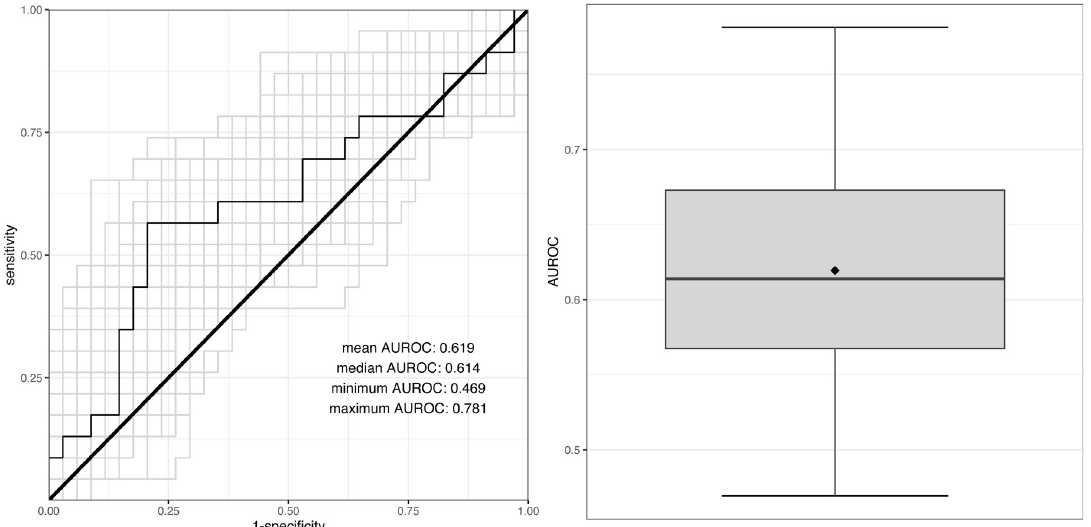
Fig 4. ROCs for all iterations of the modeling procedure to predict CMV DNAemia (left) and the associated AUROCs (right). In the left plot, the ROC that produced the median AUROC is plotted in black, and the remaining ROCs are plotted in grey. In the right boxplot, the median AUROC is shown by the black line, and the mean AUROC is shown by the